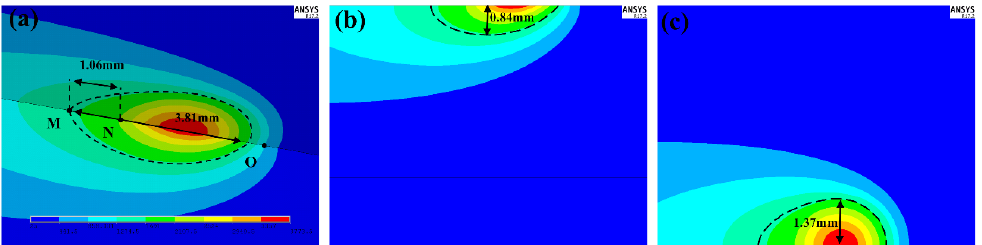
Figure 5. Morphology of molten pool ( a ) Three-dimensional morphology; ( b ) the main view; ( c ) the prone view.